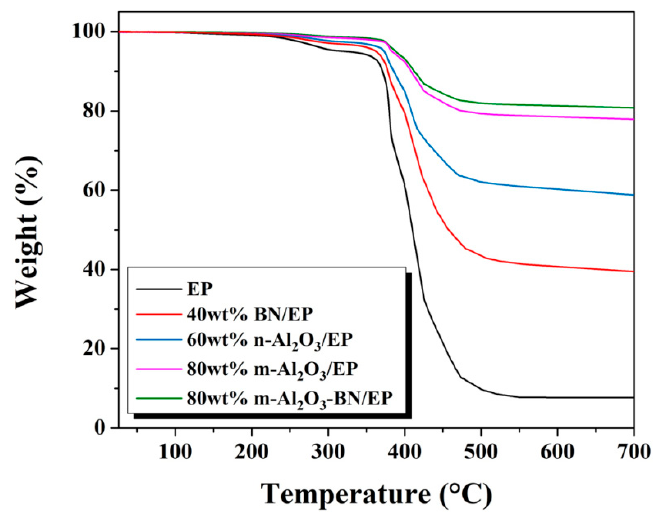
Figure 11. TGA curves of various EP composites.